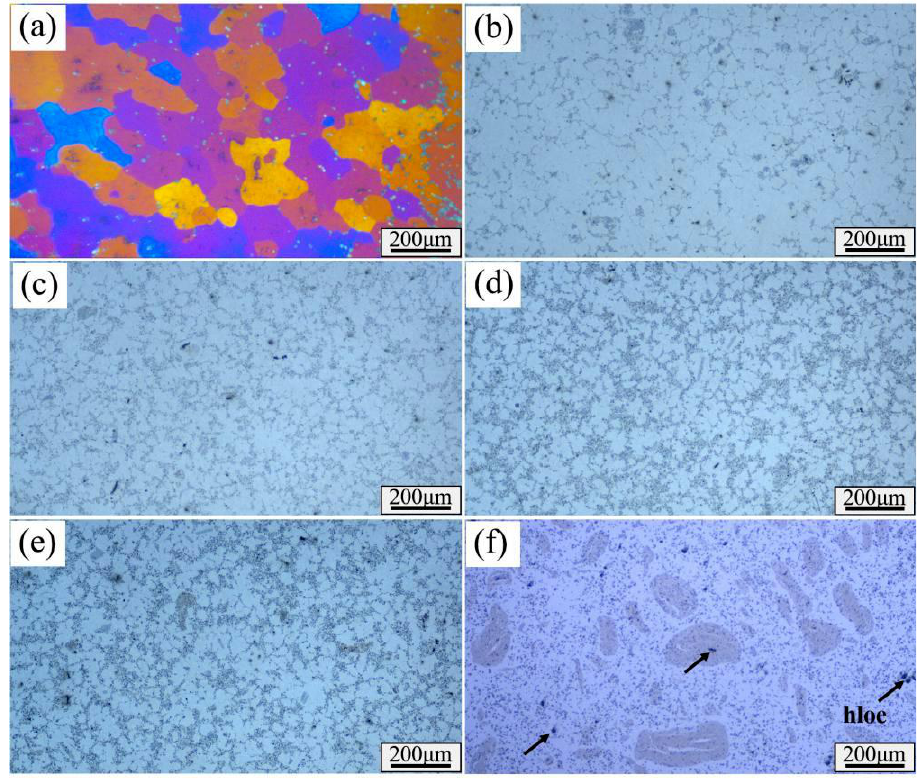
Figure 5. OM image. ( a ) Al-Cu-Mg-Si alloy; ( b ) 0.5 wt% CNTs/Al-Cu-Mg-Si composites; ( c ) 1.0 wt%